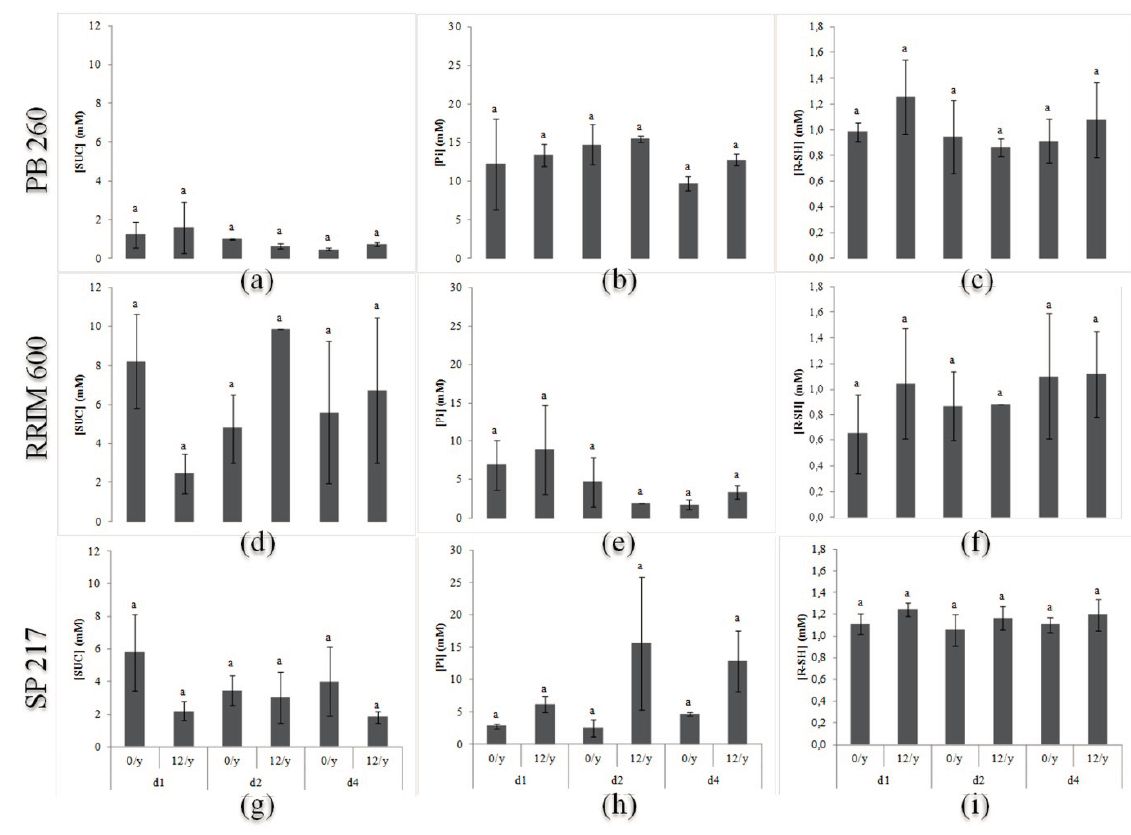
Figure 3. Sucrose (SUC; a , d , g ), inorganic phosphorus (Pi; b , e , h ) and thiol (R-SH; c , f , i ) contents for three rubber clones (PB 260, RRIM 600, and SP 217) with contrasting latex metabolism 12 months after first tapping. The ANOVA test and the Newman–Keuls test were used in the statistical analyses ( p <